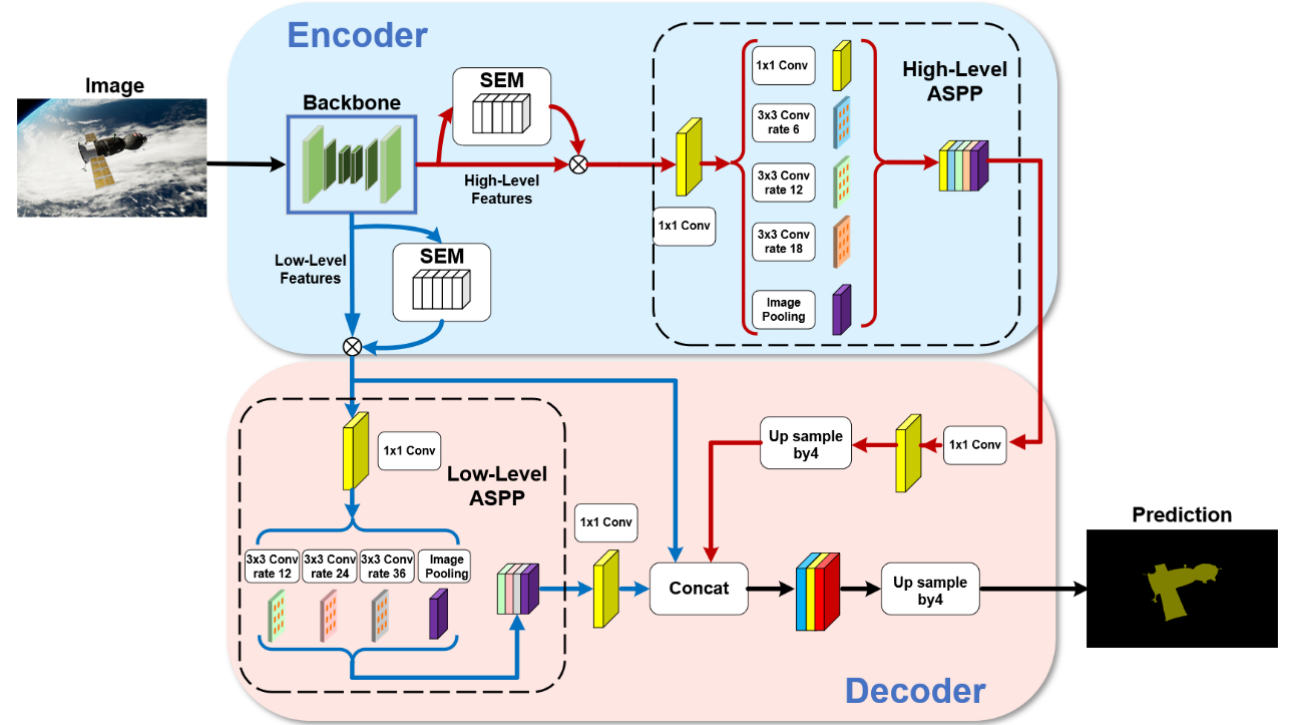
Figure 2. The structure of the semantic segmentation network for spacecraft images.